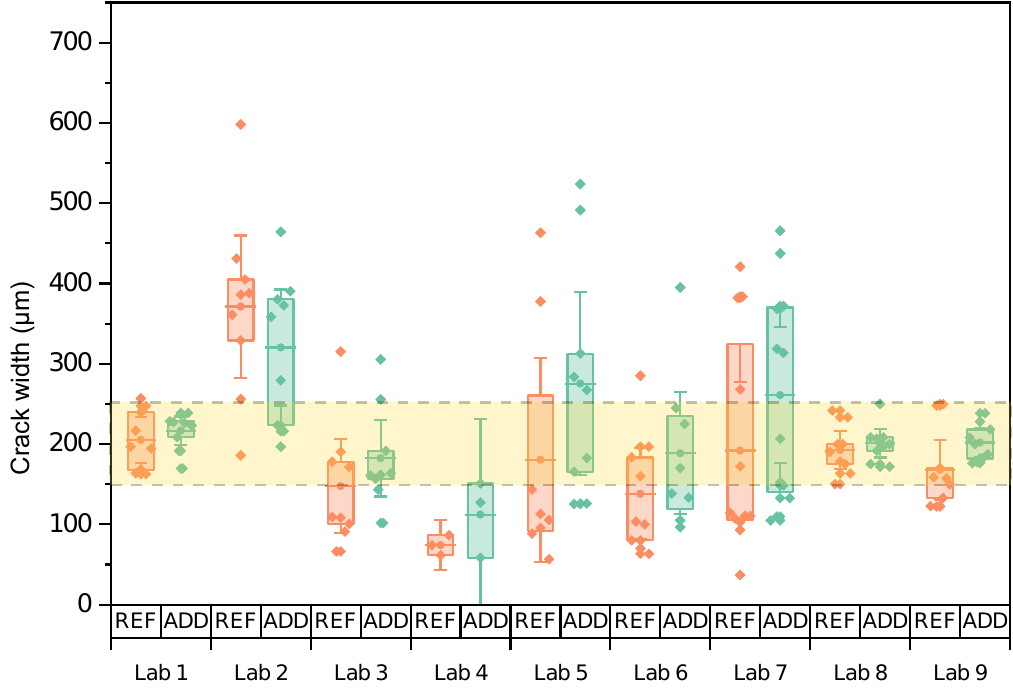
Figure 7. Crack width of individual disc specimens for which the mean of the series is indicated by horizontal lines, and error bars give the 95% confidence interval on this mean. The area between the two dotted lines indicates the desired crack